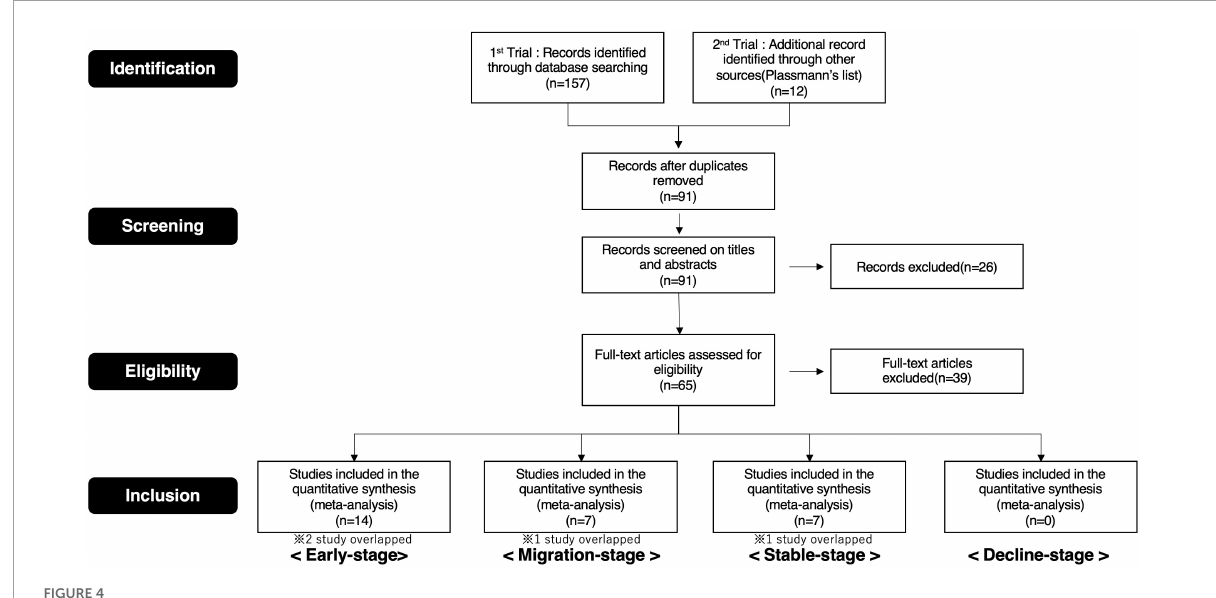
FIGURE4 PRISMA flow diagram (brand love